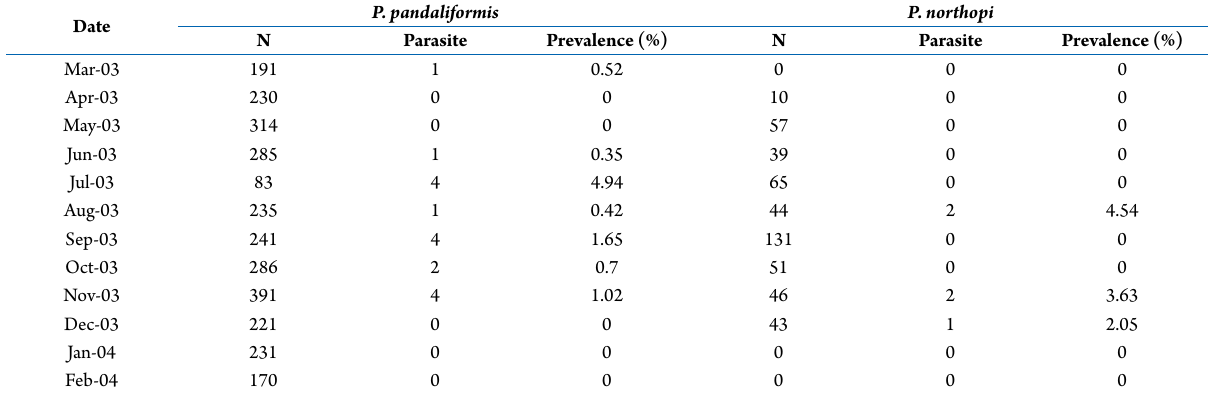
Table 2. Prevalence of Probopyrus sp. in Palaemon species at the Ubatumirim River estuary, southeast coast of